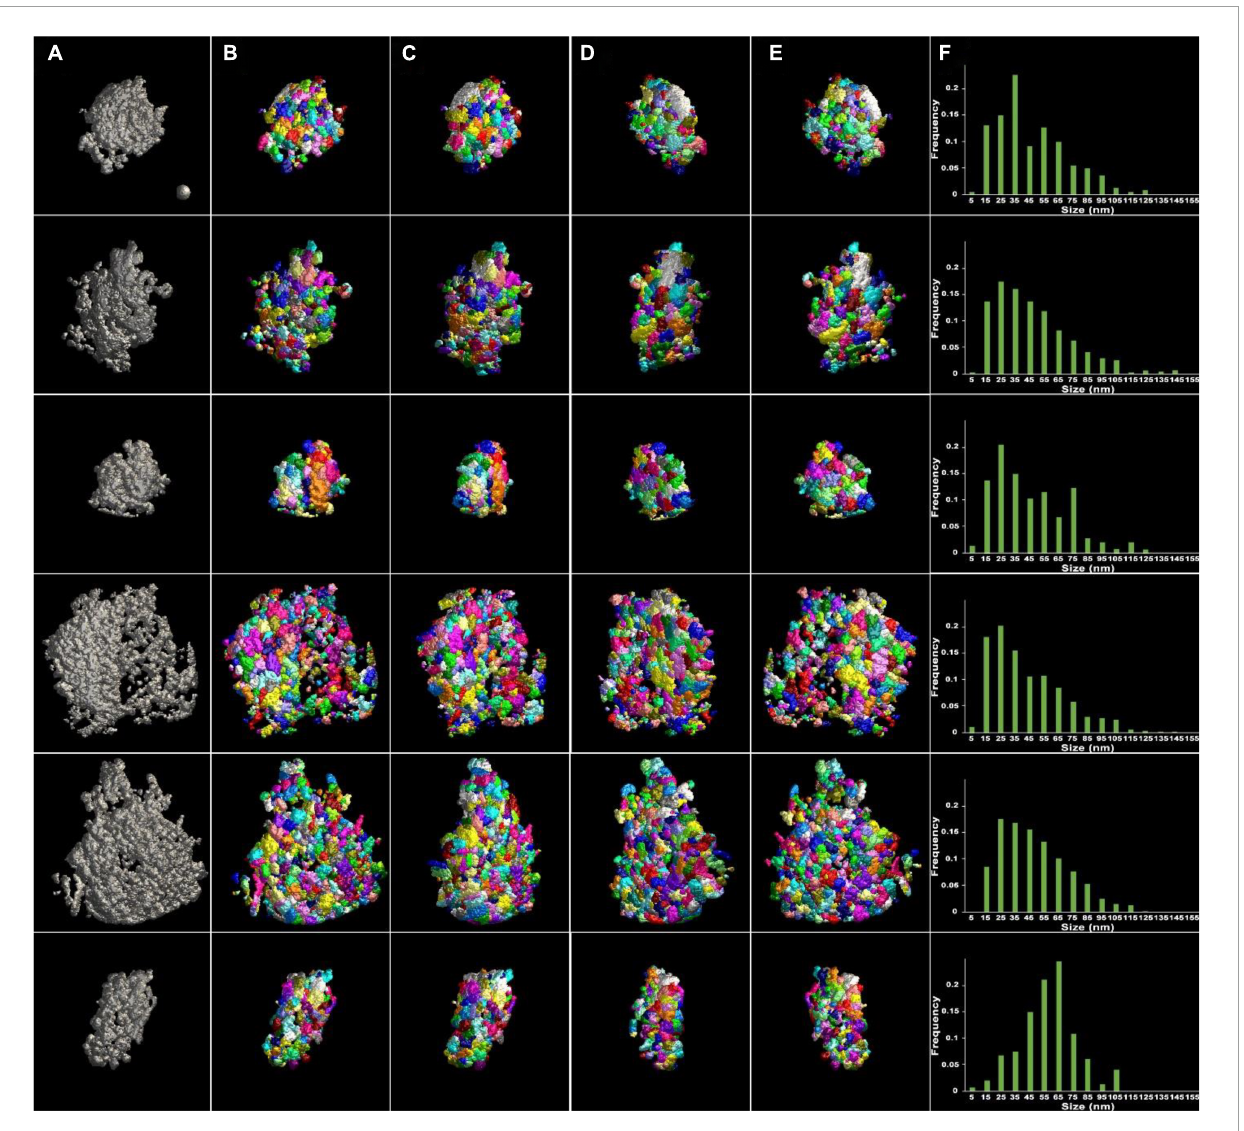
FIGURE3 Surface models of unsonicated PSDs and their modules viewed at four different angles after segmentation. (A) Surface models of six different PSDs in gray after application of ASOM, visualized en face . The surfaces of the PSDs were irregular and lumpy. Holes or gaps were present in some of the PSDs (see the fourth and fifth PSDs). The PSDs separated into modules by the 3D watershed segmentation and color-coded were viewed (B) en face , (C) after ∼ 45-degree rotation, (D) after ∼ 135-degree rotation, and (E) from behind. (F) Histograms of the size of PSD modules. The distributions were asymmetric and skewed to the left except for one distribution (sixth distribution). Most modules were less than 125 nm in size, and the average size was ∼ 50 nm. A sphere of 50 nm in diameter in the first panel (A) was included as a guidance of the